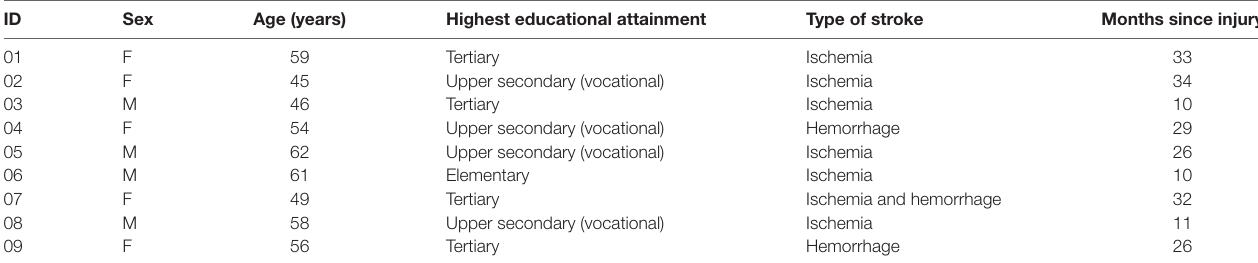
TABLE 2 | Sample characteristics.